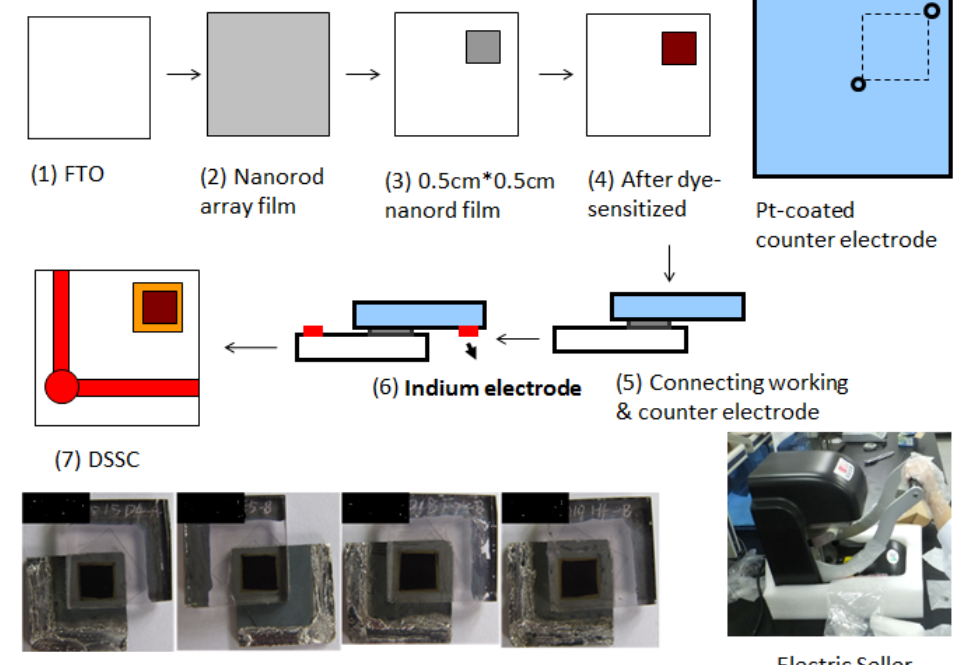
Figure 2. Schematic illustration of Au (0.0, 0.5, 1.0 and 1.5 wt %)-doped ZnO–Sm solar cells .